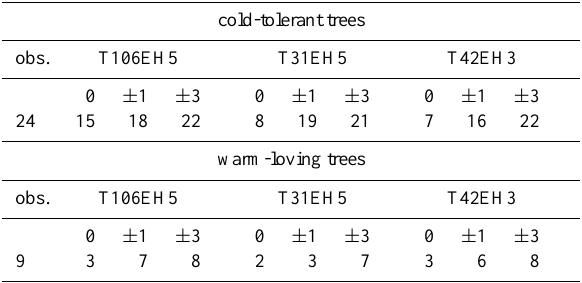
Table 9. Number of continental sites with observed tree growth where the simulations suggest possible tree growth at the grid point nearest to the site (0), within ± 1 grid point, and within ± 3 grid points ( ± 1 . 5 ◦ ) from the